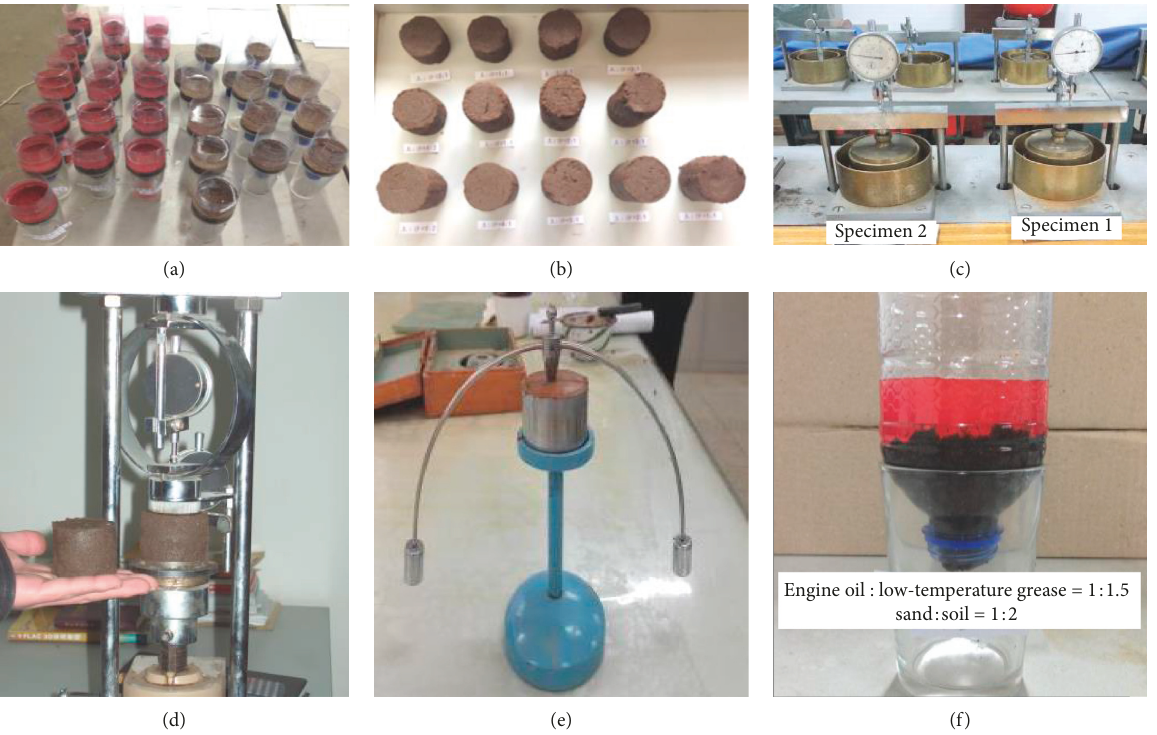
Figure 1: Simulation material testing process. (a) Specimen for simulation material. (b) Water-resisting performance testing. (c) Material concretion testing. (d) Compressive strength testing. (e) Liquid and plastic limit testing. (f) Permeability coefficient